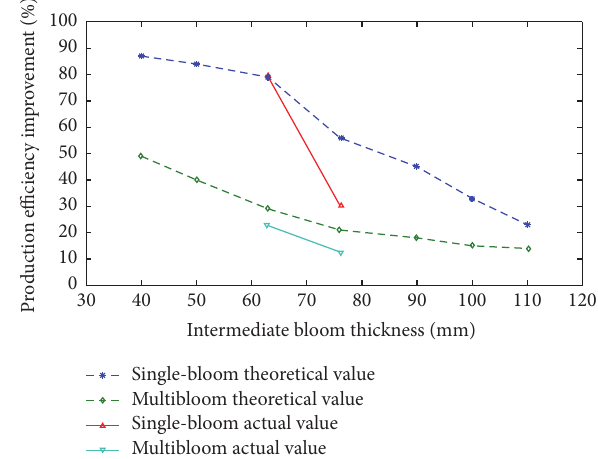
Figure 6: Comparison of the actual value and the theoretical value on production efficiency improvement of intermediate